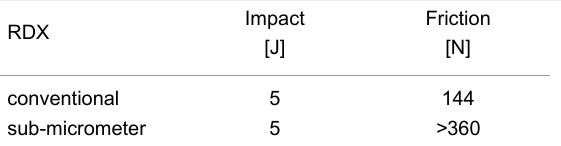
Table 5: Comparison of the sensitivity levels of conventional and 500 nm diameter RDX [46].